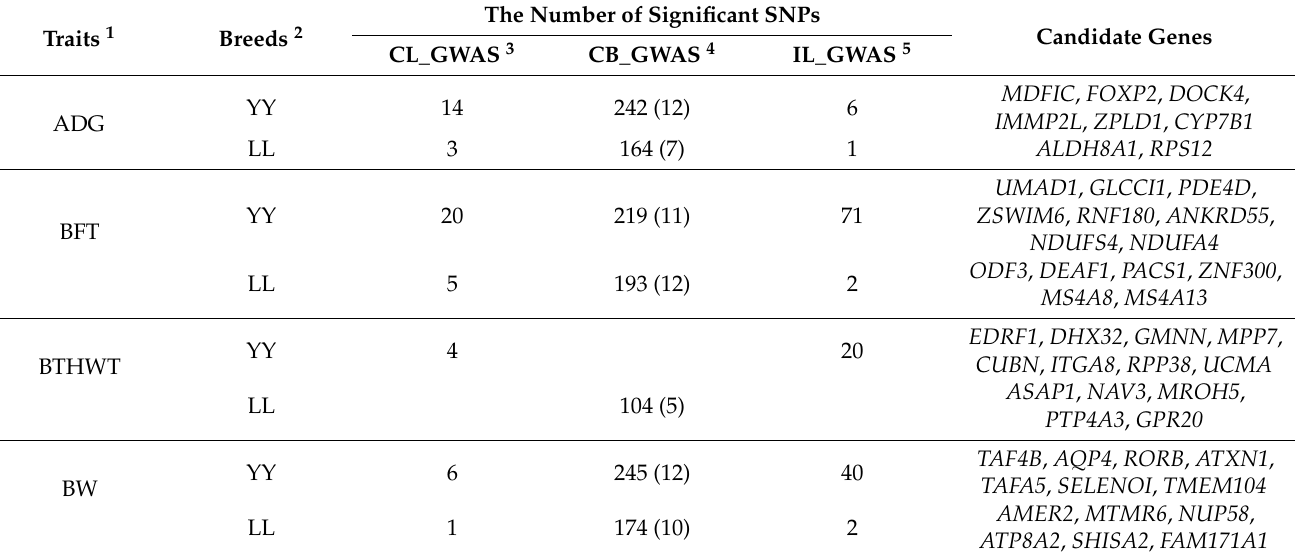
Table 2. Summary of genomic regions significantly associated with growth-related traits of three statistical